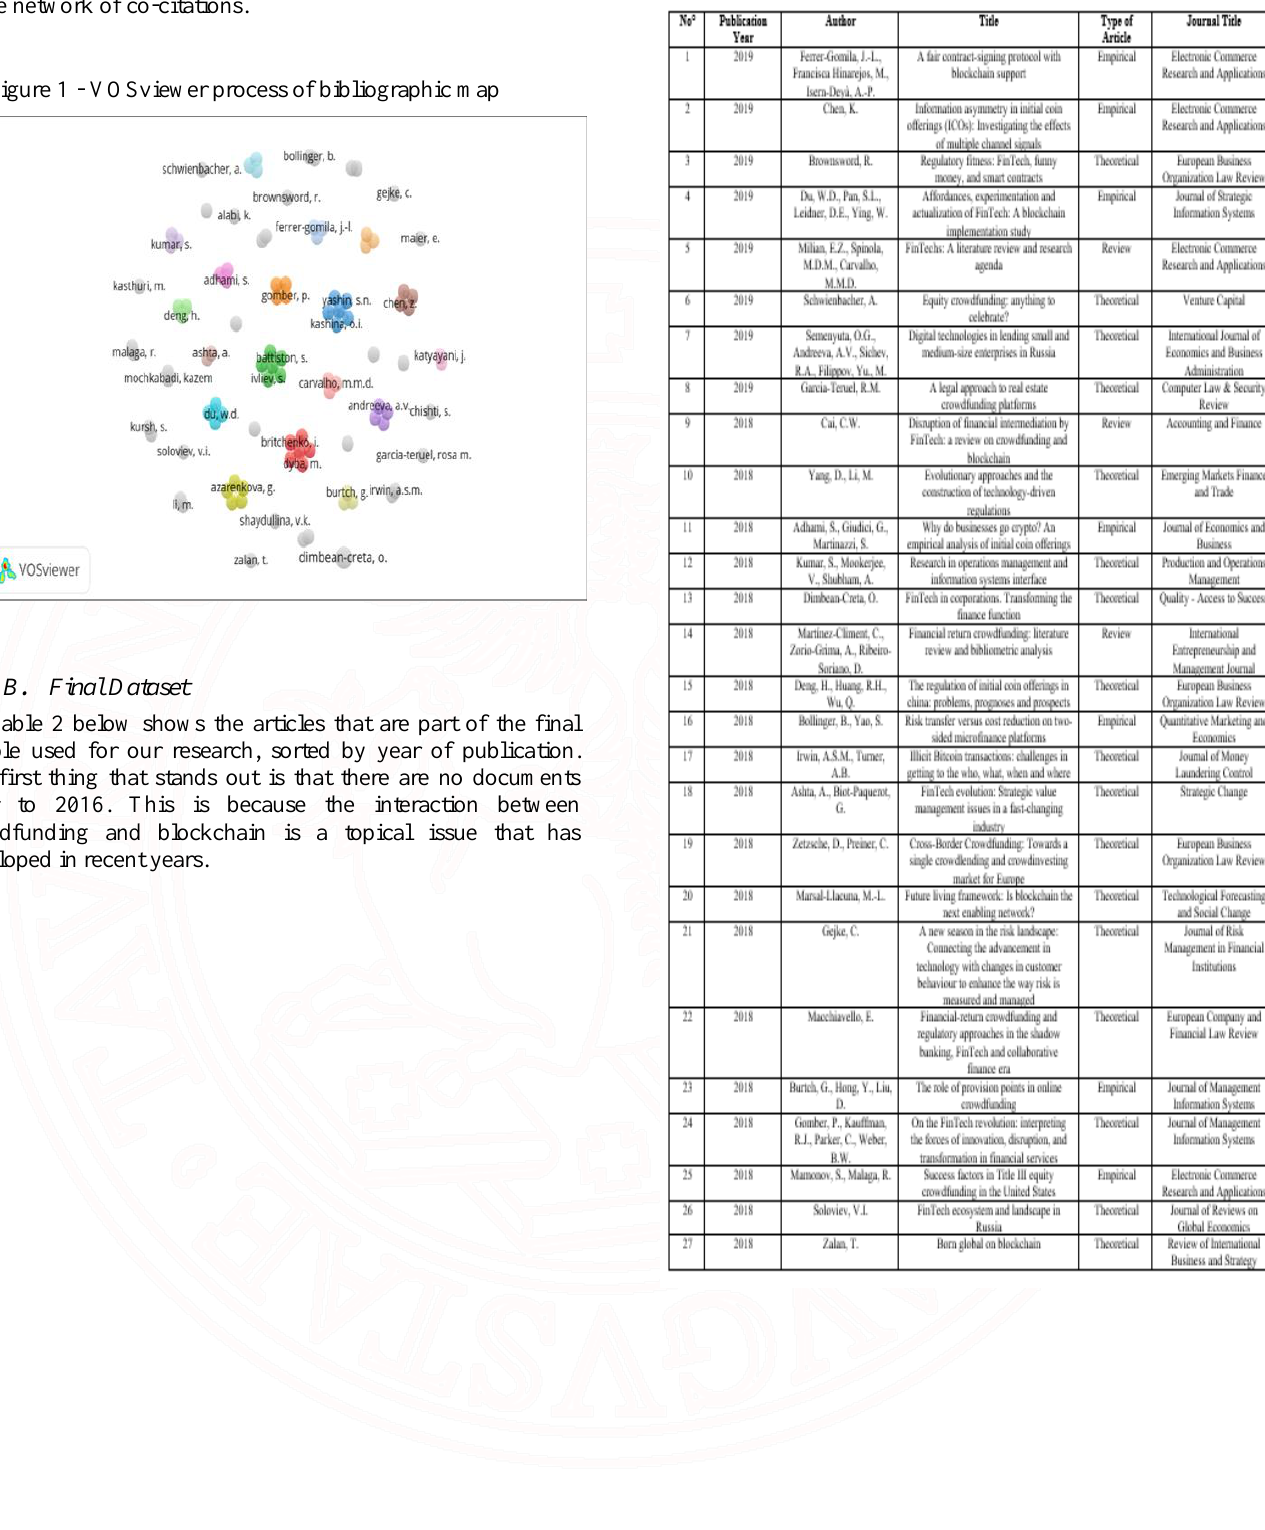
Table 2 - List of articles used as